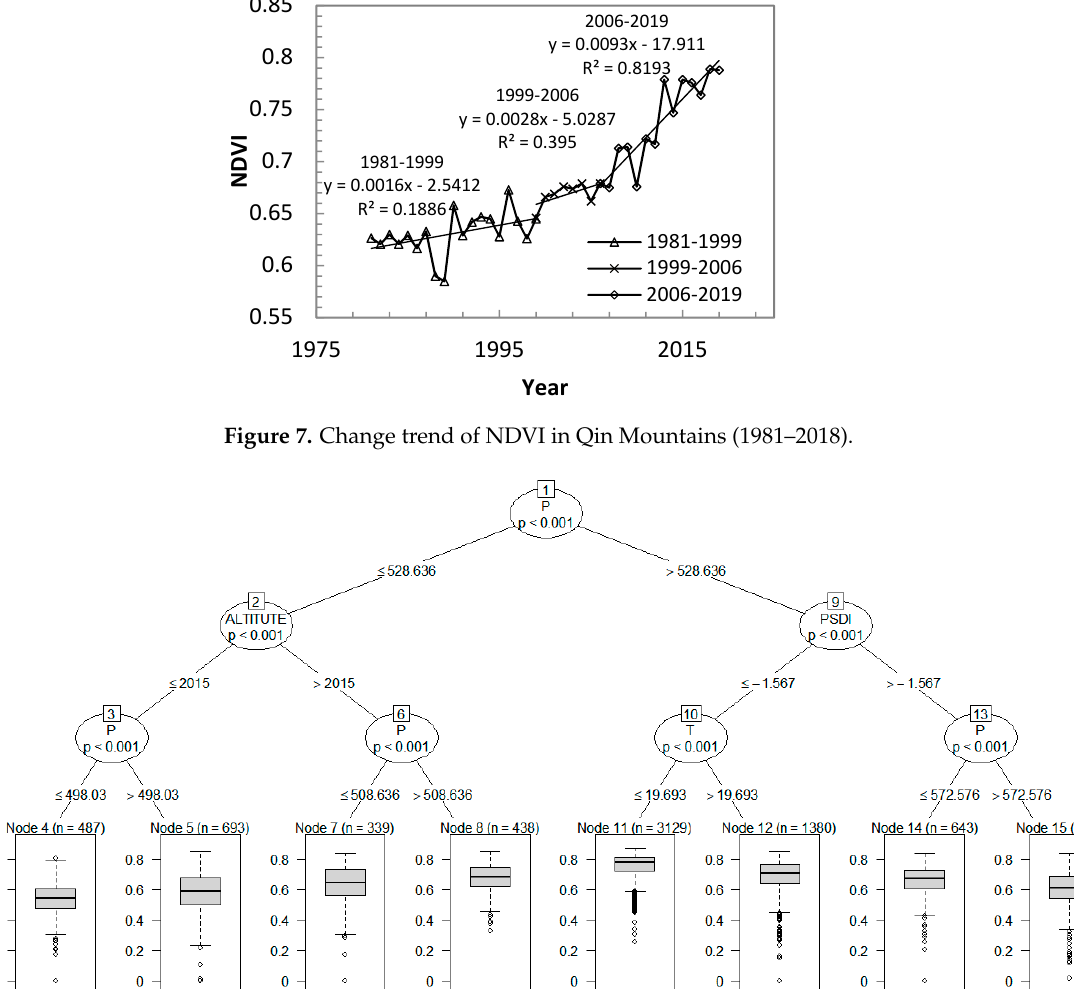
Figure 8. NDVI factor interactions derived from the Classification and Regression Trees (CART).